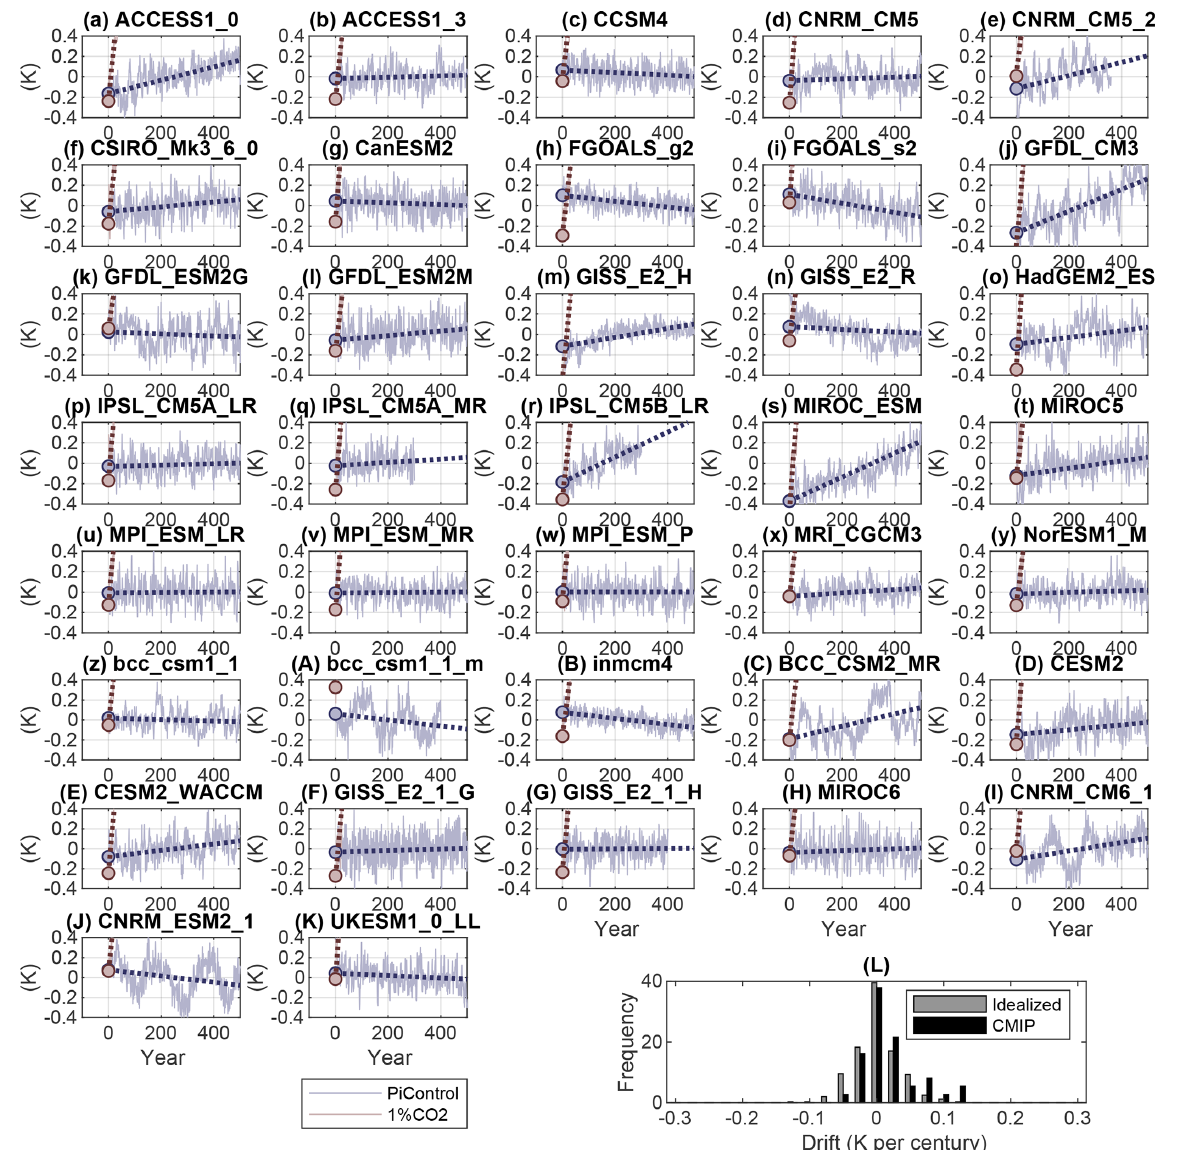
Figure 4. (a–k) Control simulation global mean temperatures from a selection of models in the CMIP5 and CMIP6 ensembles. Control simulations (blue) and initial years of 1pctCO2 simulations (pink) are plotted. Dotted lines show linear fit to the available time series. Blue and pink circles show the intersection of the linear temperature fit at the start of the simulation. (l) Histogram showing the distribution of control model trend in CMIP (black) and in an idealized ensemble of non-equilibrated simple models considered in Fig. 5